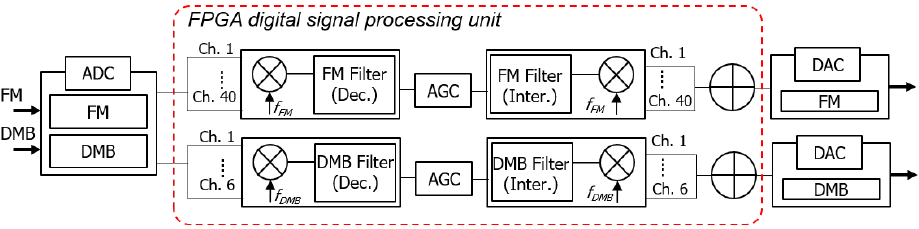
Figure 12. Block diagram of the designed FPGA-based digital-signal-processing